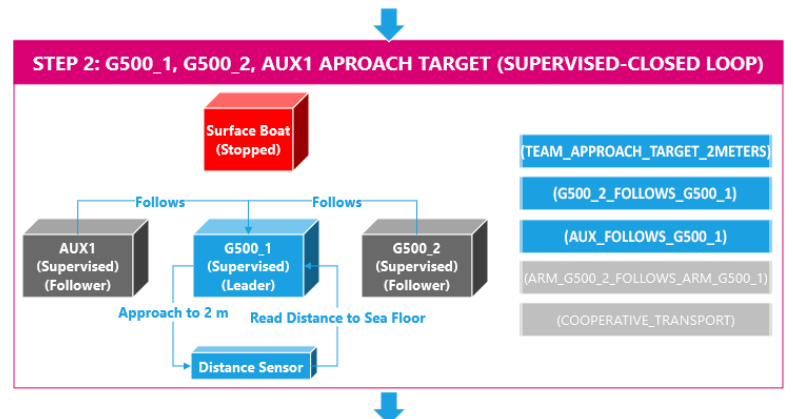
Figure 11. Cooperative robotics mission plan (step 2): cooperative behaviours are activated to make the robot team approach the seabed.